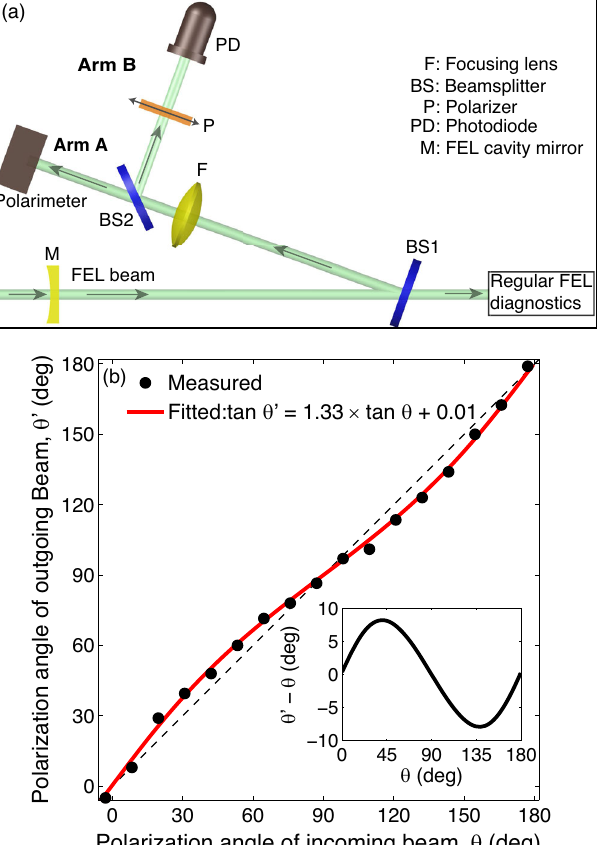
FIG. 2. (a) Layout of the prototype FEL polarimeter with two nonpolarizing beam splitters (BS1 and BS2), a focusing lens (F), a linear polarizer (P), a commercial polarimeter, and a photodiode (PD). (b) Polarization angle measured in arm B as a function of the polarization angle of an incoming linearly polarized beam at 548